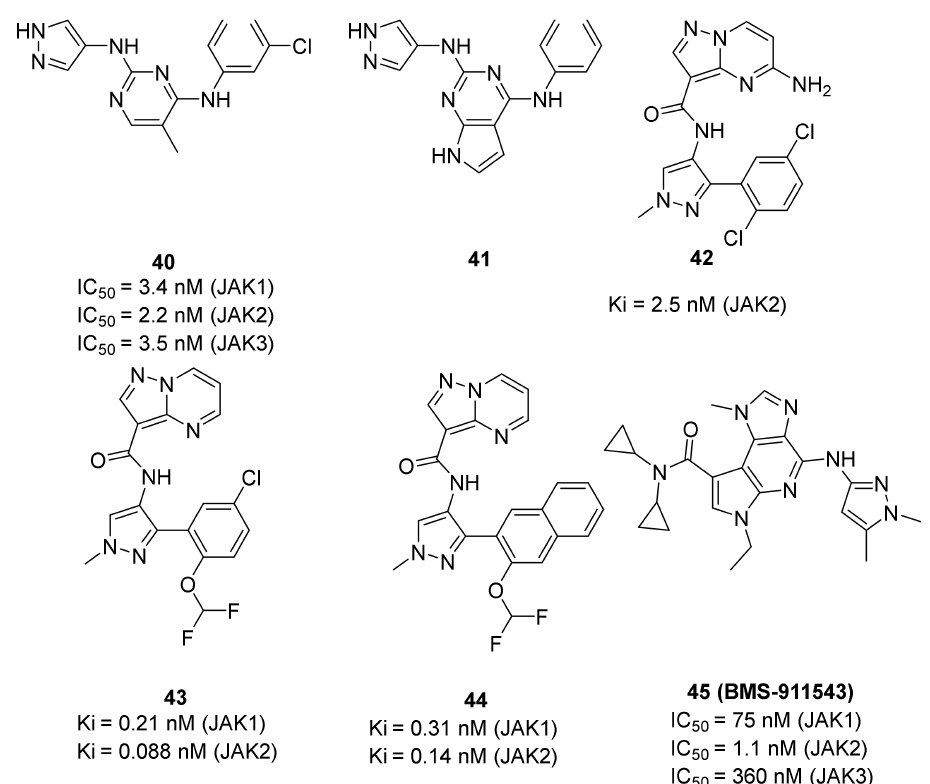
Figure 43. Structures of pyrazole-based JAK inhibitors and their IC 50 /Ki values.